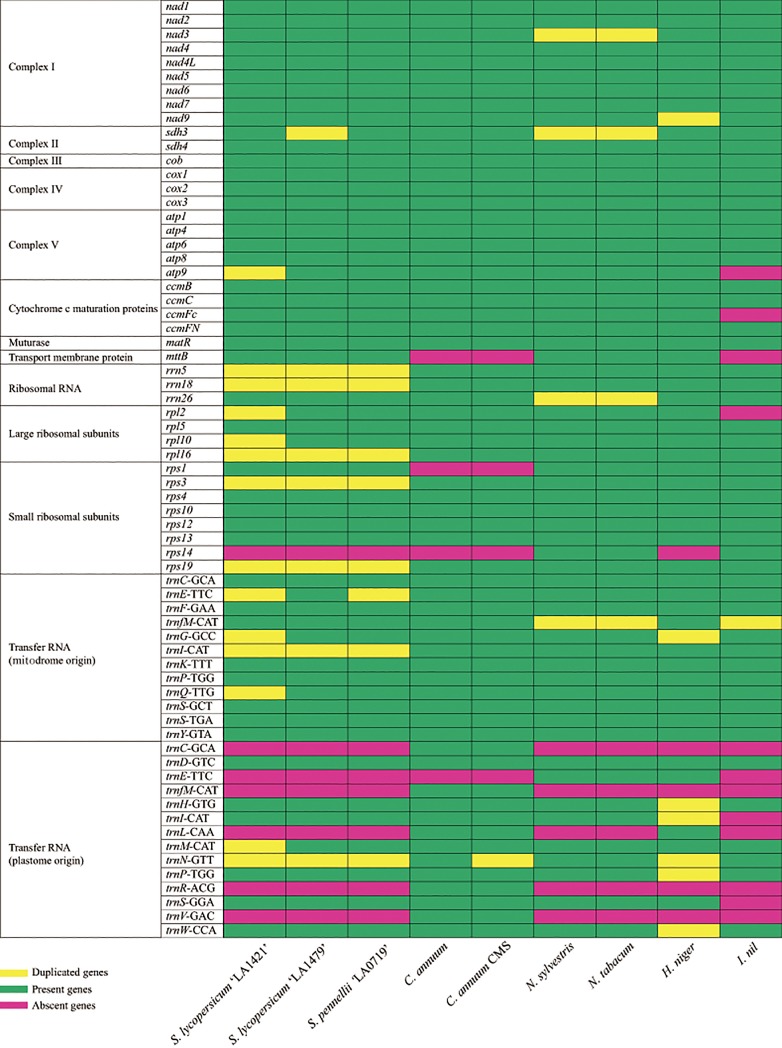
Genes present in the mitogenomes of tomato species and related species belonging to the Solanales.